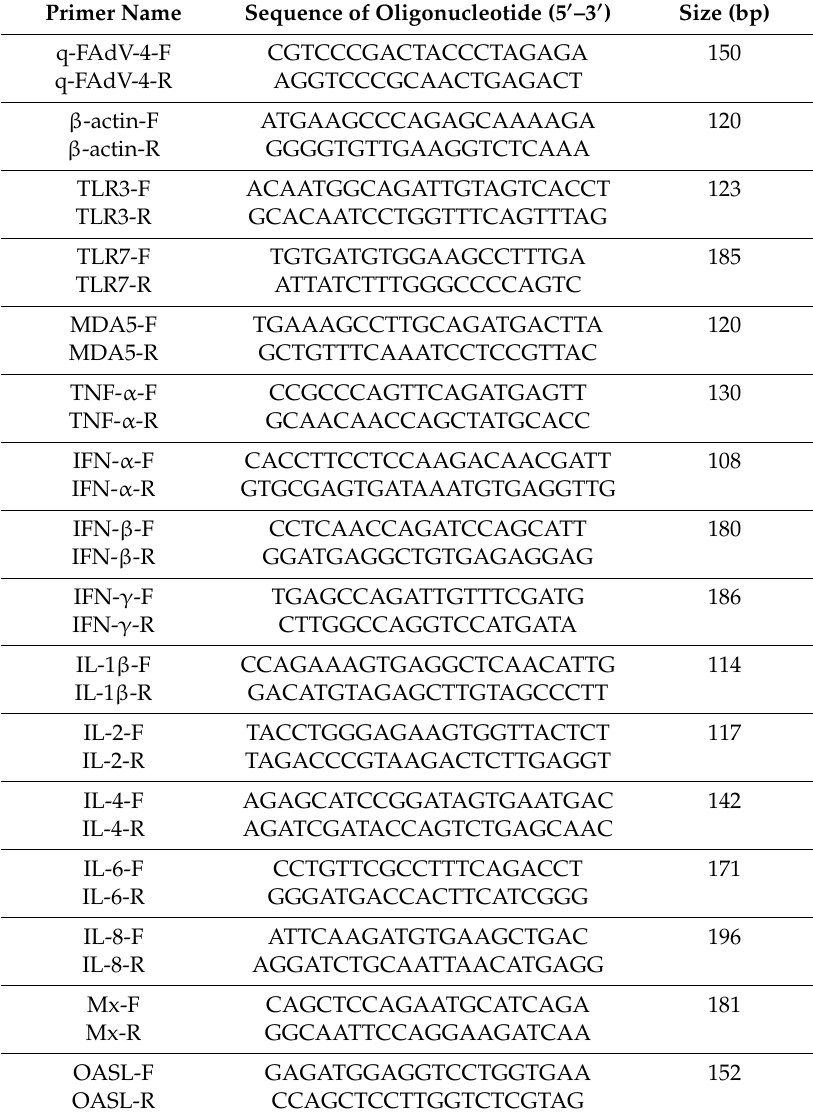
Table 2. Primers used in this